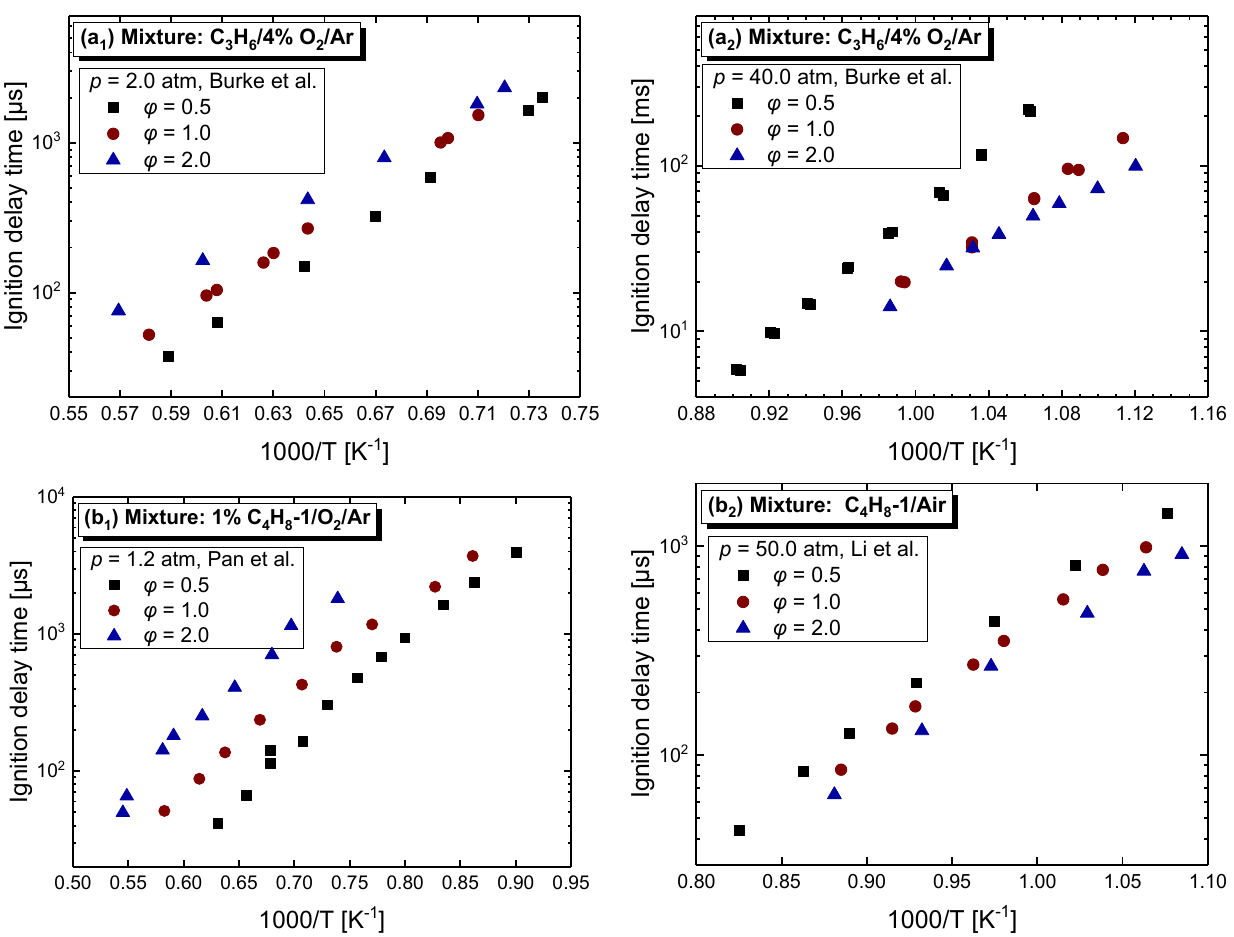
Figure 14. Equivalence ration dependence for IDTs of propene and 1-butene. ( a 1 )/( a 2 ) Propene, symbols are experimental IDTs from Burke et al. [39]; ( b 1 )/( b 2 ) 1-butene, symbols are experimental IDTs from Pan et al. [42] and Li et al. [43].